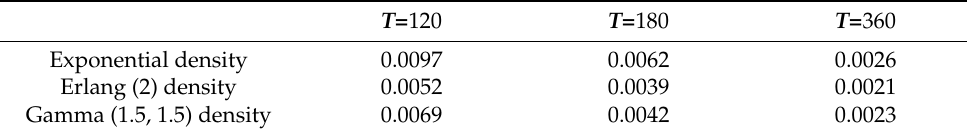
Table 1. IMSEs of ruin probability estimation for different claim distributions and T